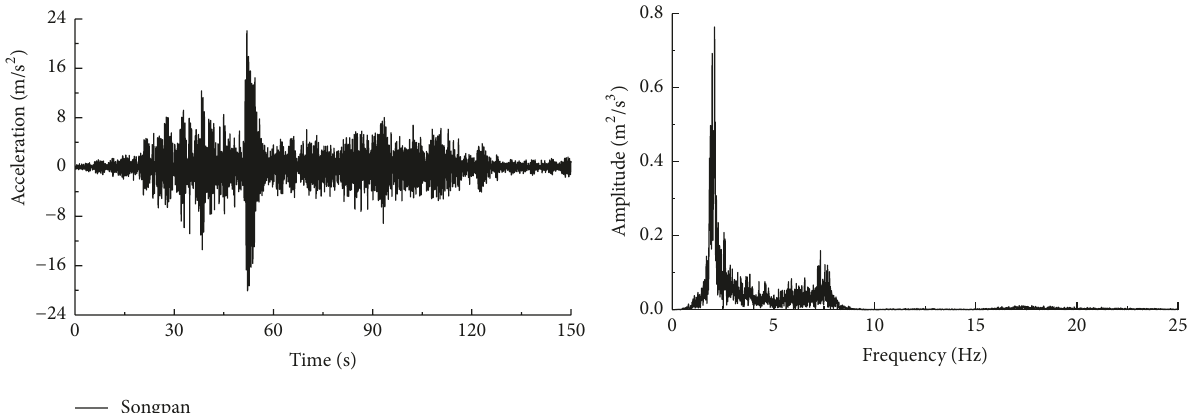
Figure 21: Horizontal acceleration time history and Fourier spectrum curves at node 103 under Songpan wave (HV case).